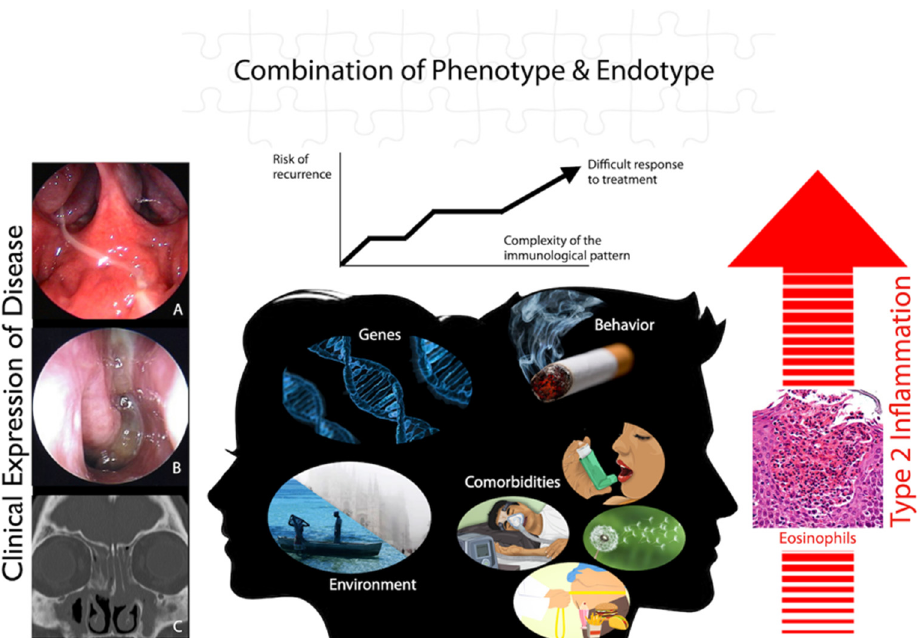
Figure 2. Genetic, environmental, and behavioral factors contribute, together with comorbidities, to determine the degree of upper airway type-2 inflammation, with consequences for clinical expression and severity (e.g., recurrence after surgical treatment) of chronic rhinosinusitis. ( A ) Post-nasal drip, as an example of pure upper airway inflammatory involvement; ( B ) Chronic rhinosinusitis with nasal polyps, a more structured inflammatory condition; ( C ) CT-scan with extended chronic rhinosinusitis with concomitant bone remodeling as a consequence of chronic in fl ammation.